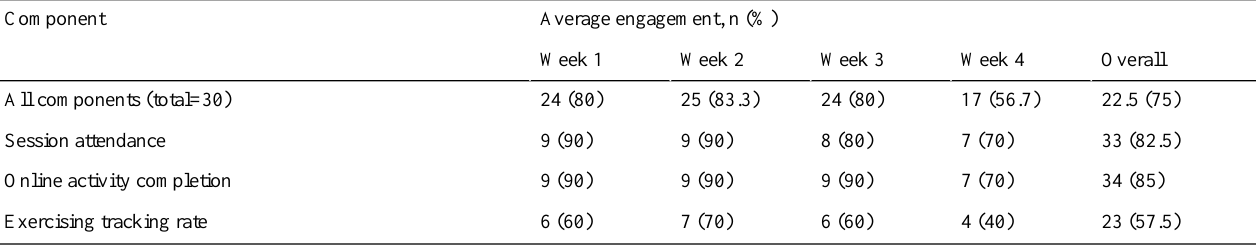
Table 3. Average engagement for the 3 components of the